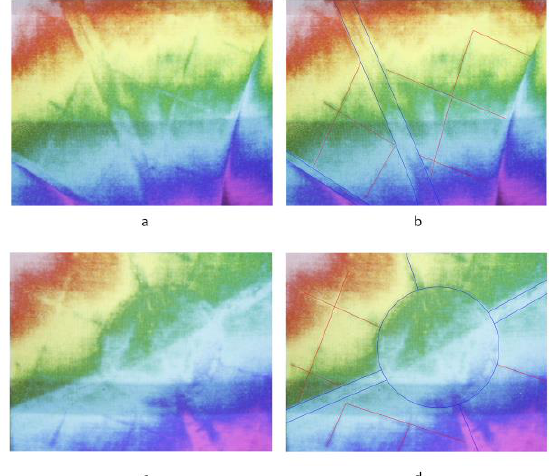
Figure 7 : Enhancement of hidden lattice as support for detached